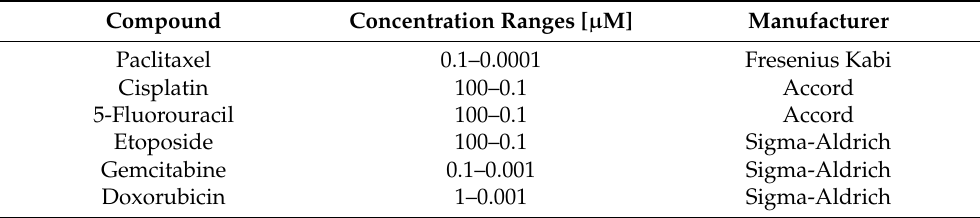
Table 3. Set of compounds and their concentration ranges utilized for antiproliferative